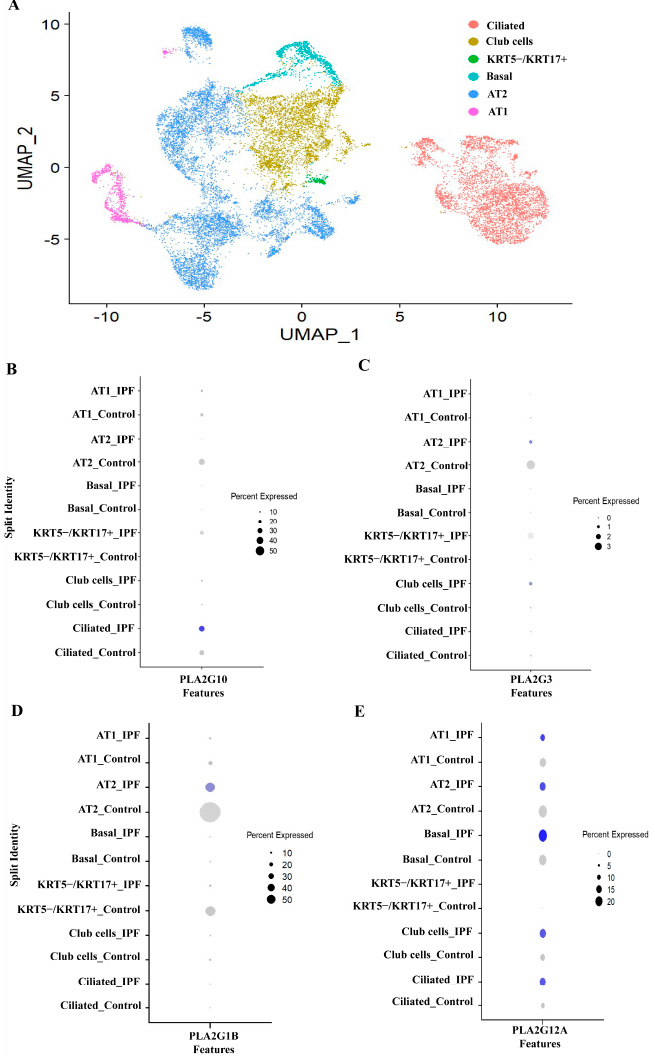
Figure 5. Analyzing expression of PLA2G10 and PLA2G3 in epithelial cells ( A ) UMAP showing the distribution of various clusters of epithelial cells. ( B – E ) Dot plot visualization of expression of PLA2G10, PLA2G3, PLA2G1B and PLA2G12A in epithelial cells from Control and IPF patients.